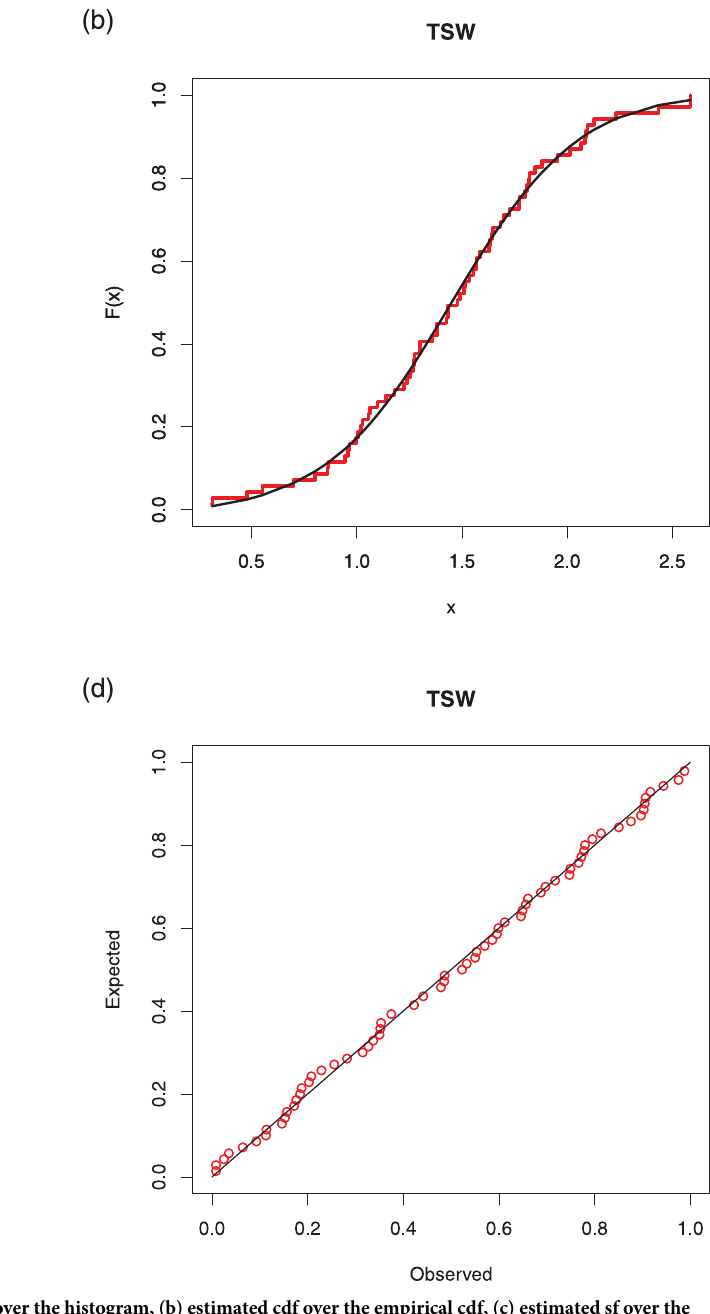
PLOS ONE | https://doi.org/10.1371/journal.pone.0250790 May 11,